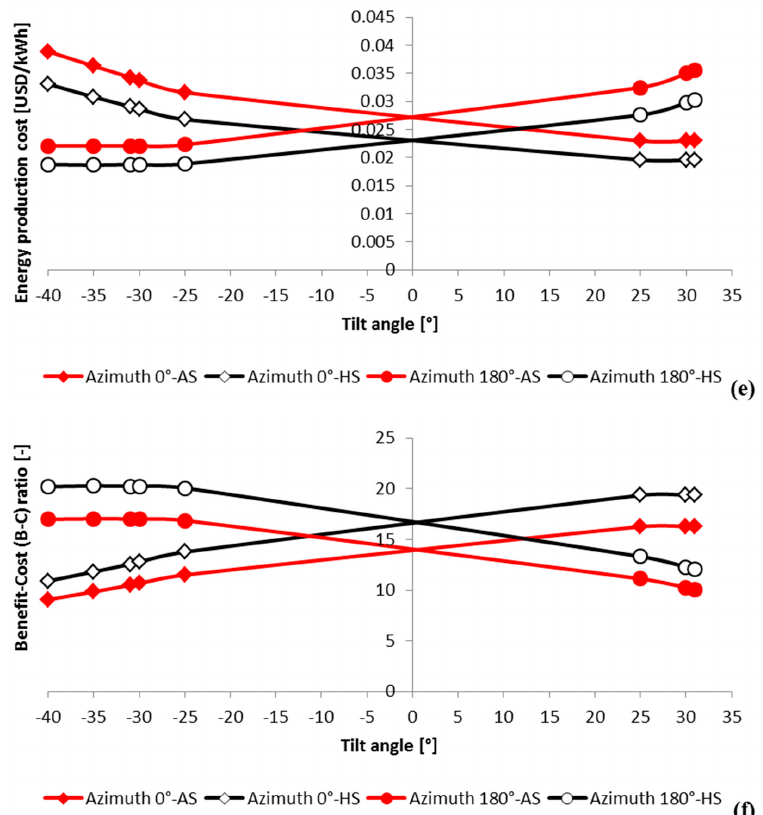
Figure 10. Impact of the azimuth and tilt angle on the economic performance of the proposed PV system; ( a ) net present value, ( b ) annual life cycle savings, ( c ) simple payback, ( d ) equity payback, ( e ) energy production cost and ( f ) benefit-Cost (B-C) ratio (AS: AS-M60-310W; HS: HS166-380-120M) .